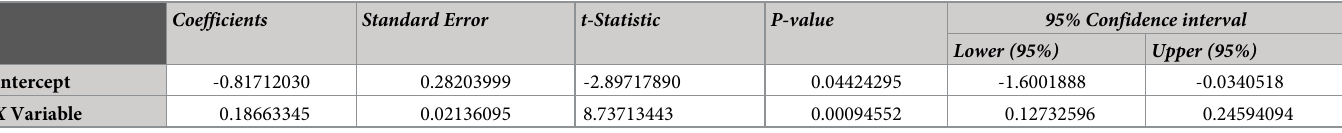
Table 2. The linear regression output for the fitted linear regression model to the log cumulative number of cases plotted against time for segment of initial rise of cases during the 2015 Nyimba district bubonic plague outbreak. Coefficients